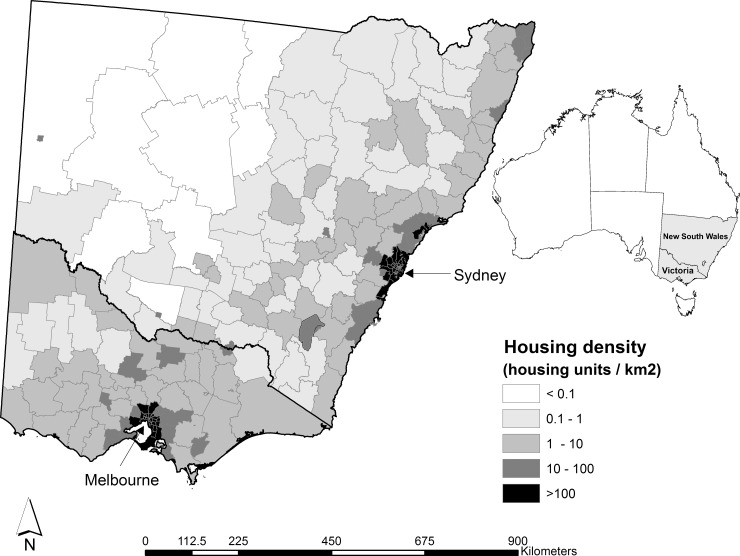
Location of study area and housing density, housing units/km2 in relation to local government areas.Source: generated from data from the Australian Bureau of Statistics 2011 Census of Population and Housing. Developed using Administrative Boundaries produced by PSMA Australia Limited licensed by the Commonwealth of Australia under Creative Commons Attribution 4.0 International licence (CC BY 4.0).